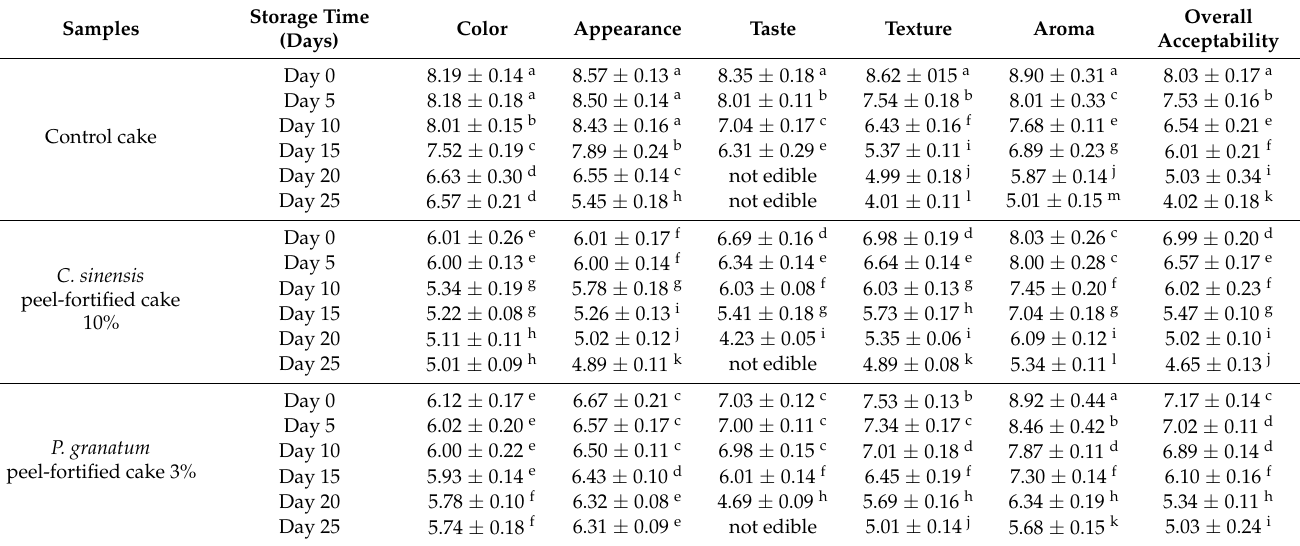
Table 13. Effect of shelf life on sensory evaluation for cake supplemented with C. sinensis and P. granatum peel powder at refrigeration temperature (3 ◦